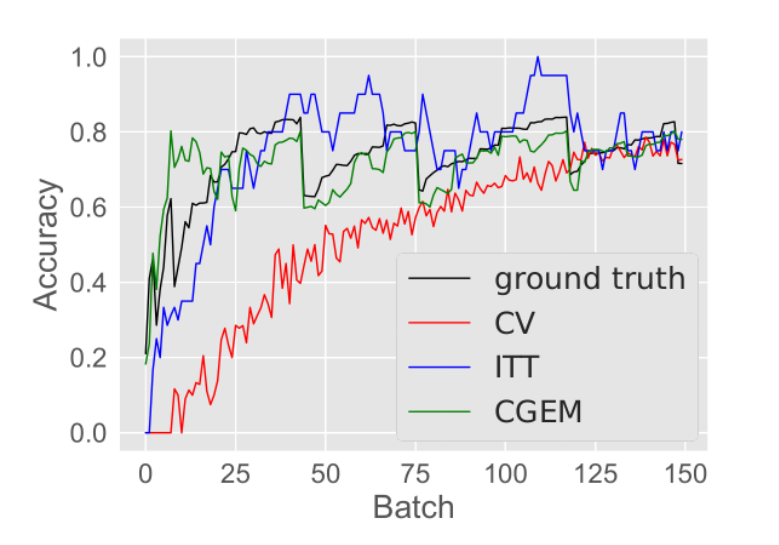
Figure 10. CGEM applied in one incremental learning use case where new classes are added to the unlabeled pool while training (noticeable in the decays of accuracy). CGEM, ITT and CV are used to estimate the ground-truth accuracy. New samples are added to the unlabeled pool, when the estimated accuracy by CGEM is over